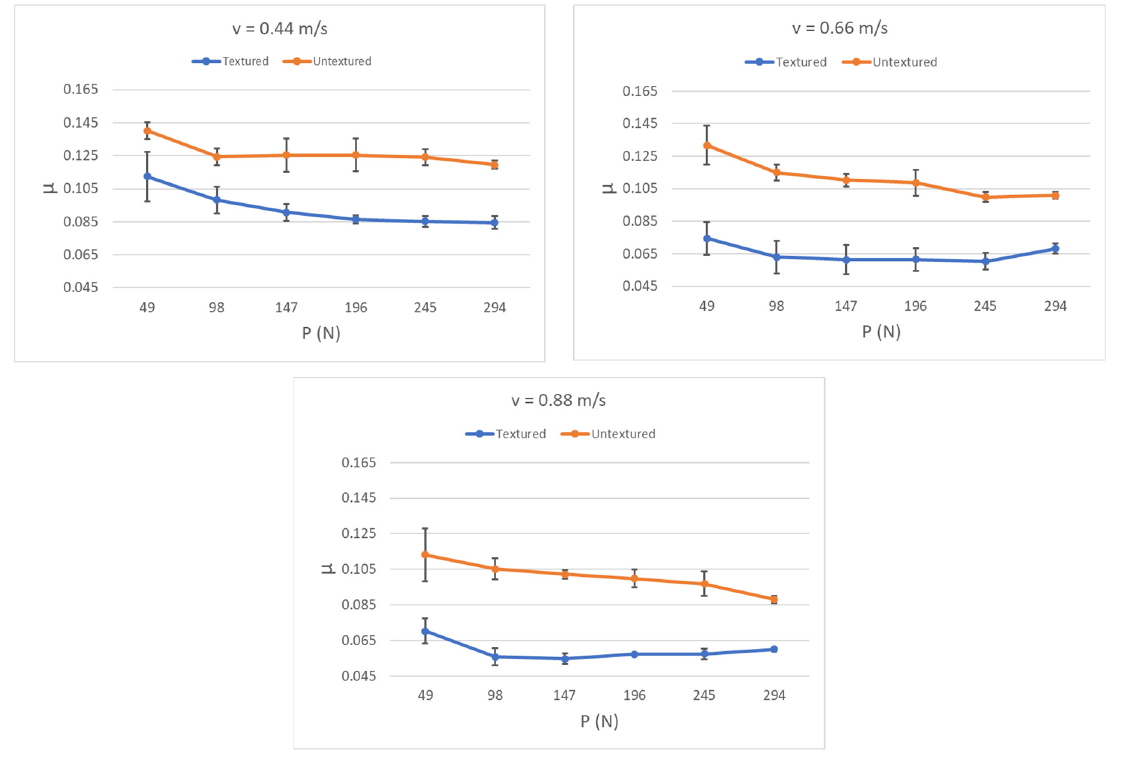
Figure 5. The effect of surface texturing of cylinder liner on the coefficient of friction of sliding assembly under full lubrication, after [67].